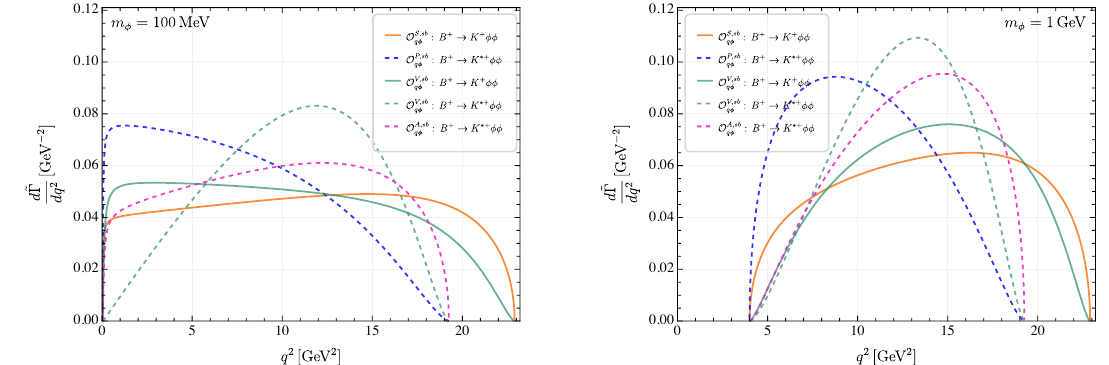
Figure 1 . Normalized differential decay width for B → K ( ∗ )+ φφ decay from different types of operators. Left panel : m = 100 MeV ; Right panel : m = 1 GeV .